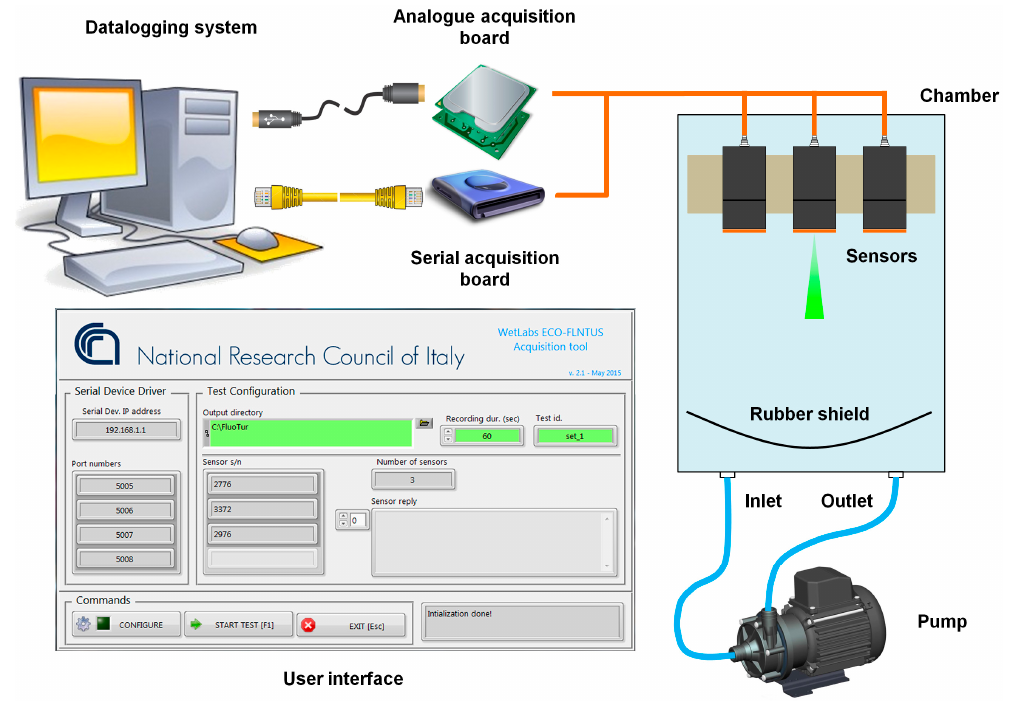
Figure 7. Sketch of the experimental setup used for the intercomparison of chlorophyll- a and turbidity sensors and user interface of the developed software